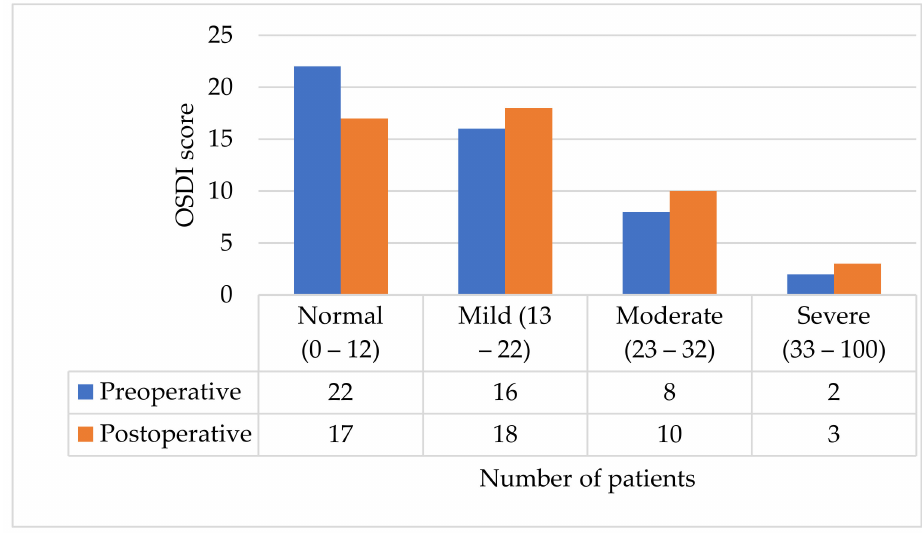
Figure 1. OSDI score before and 1 month after the